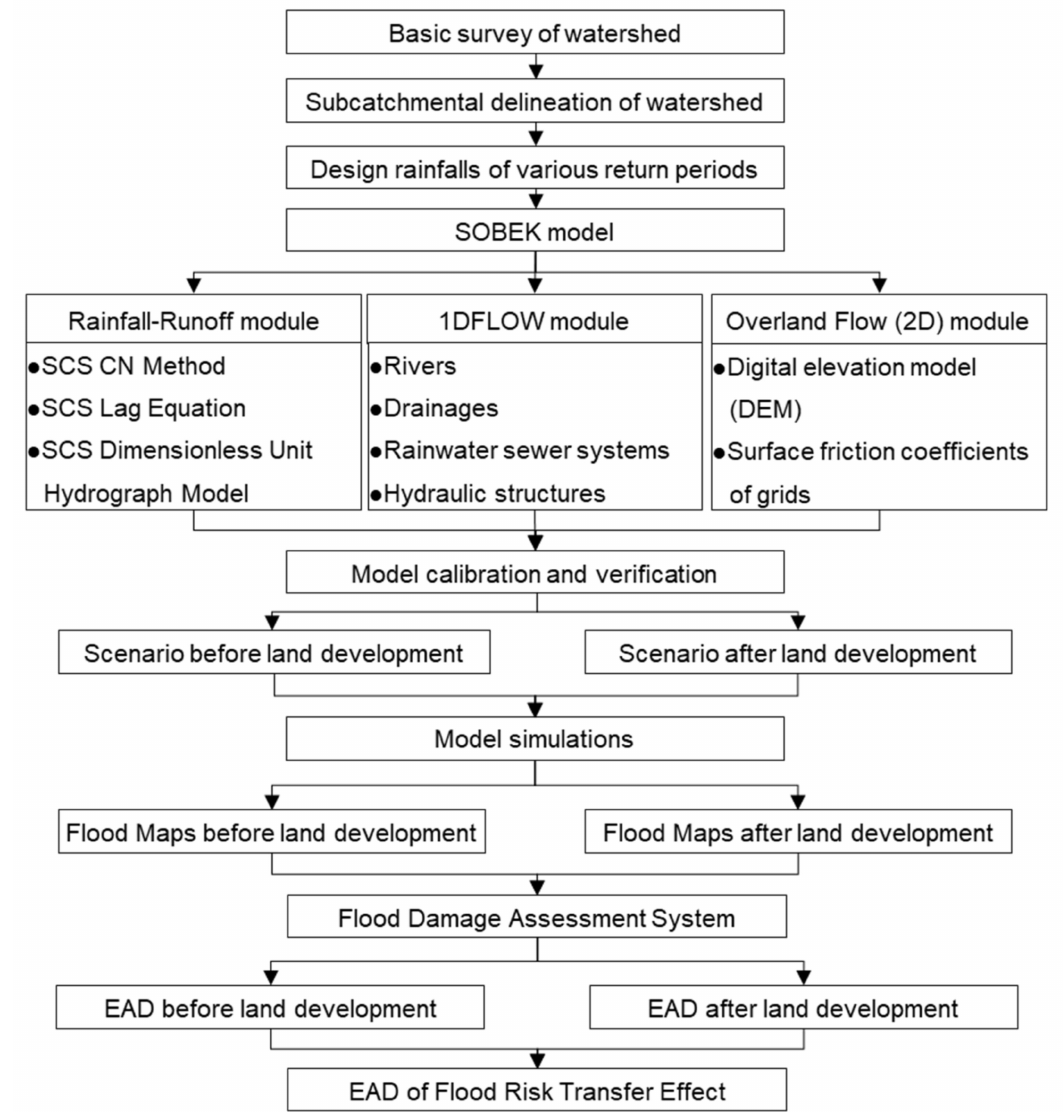
Figure 2. The flow chart of the methodology (modified from Yang et al.